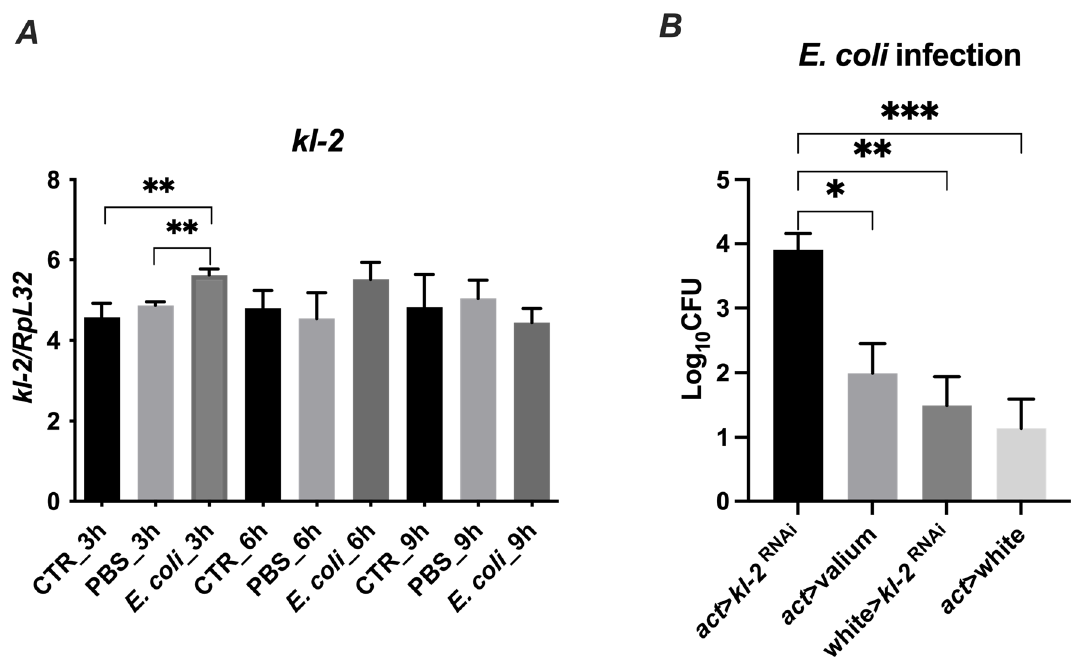
Figure 7. Gene expression ( A ) and antibacterial protection of MFF kl2 ( B ) in response to microbial challenge. ( A ) Bacteria upregulate the mRNA expression of kl-2 . Canton S flies were infected by injection with E. coli ( E. coli group), injected with PBS (PBS group) or untreated (CTR group) and collected 3 h, 6 h and 9 h after infection, and total RNA was subjected to RT-qPCR. Relative expression of kl-2 is shown as mean ± SD (N = 3 independent experiments, with 15 flies in each). Statistically significant differences between groups are indicated as ** p < 0.01 by two-tailed Student’s t -test. ( B ) Male fertility factor kl2 is bactericidal in vivo. The experimental flies ( act > kl-2 RNAi ) and controls ( act > Valium , w 118 > kl-2 RNAi , act > w 1118 ) were infected with E. coli . Three hours after infection, flies were collected and bacterial load was determined by colony-forming assay. The results are shown as means ± SEM. Statistically significant differences between groups are indicated as ***, p < 0.001; **, p < 0.01; and *, p < 0.05 by Kruskal–Wallis one-way ANOVA with post hoc Dunn’s